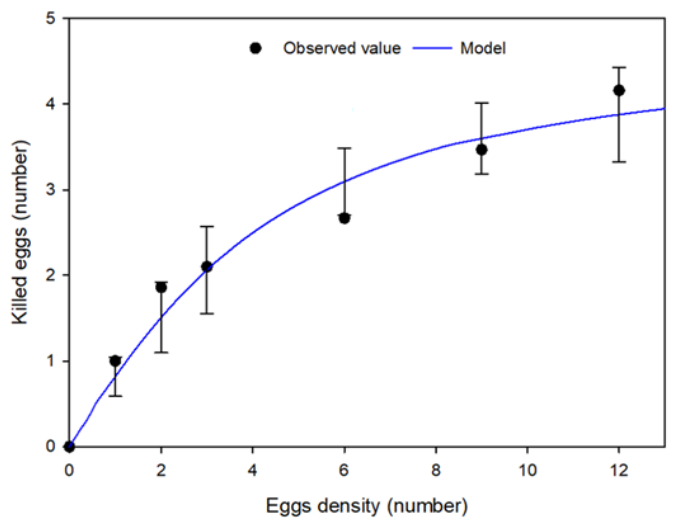
Figure 4. Functional response (number of pest eggs killed), type II, of the adult female of Blattisocius tarsalis when different densities of Tecia solanivora eggs were offered as prey for 24 h under laboratory conditions (whisker plot: 95% confidence